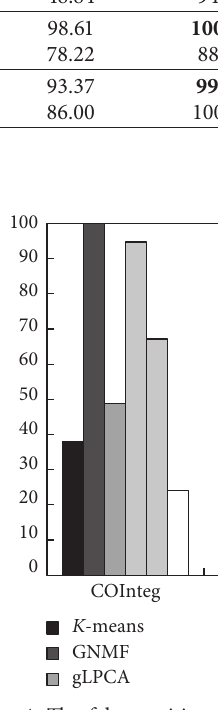
Figure 3: The true positive rates of six methods on each multi- genome